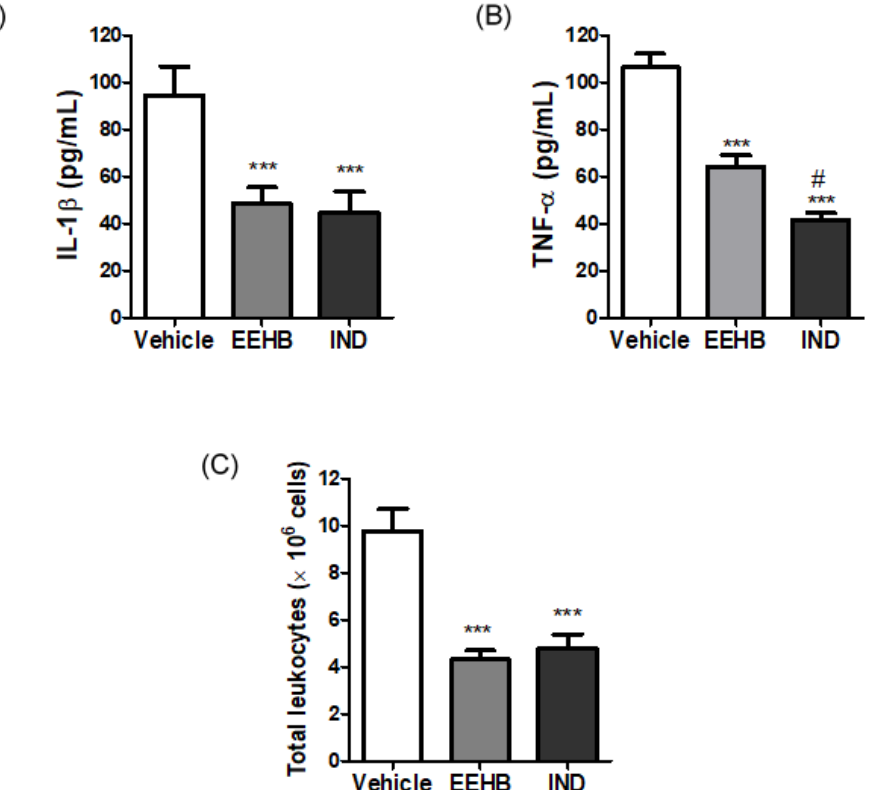
Figure 1. Anti-inflammatory evaluation of EEHB. ( A ) Interleukin-1 β (*** p < 0.001); ( B ) Tumor Necrosis Factor- α (*** p < 0.001 in relation to vehicle group and # p < 0.05 in relation to EEHB); ( C ) Total leukocytes (*** p < 0.001). All values expressed as mean ± standard deviation. ANOVA followed by Tukey’s test ( α = 0 .05).